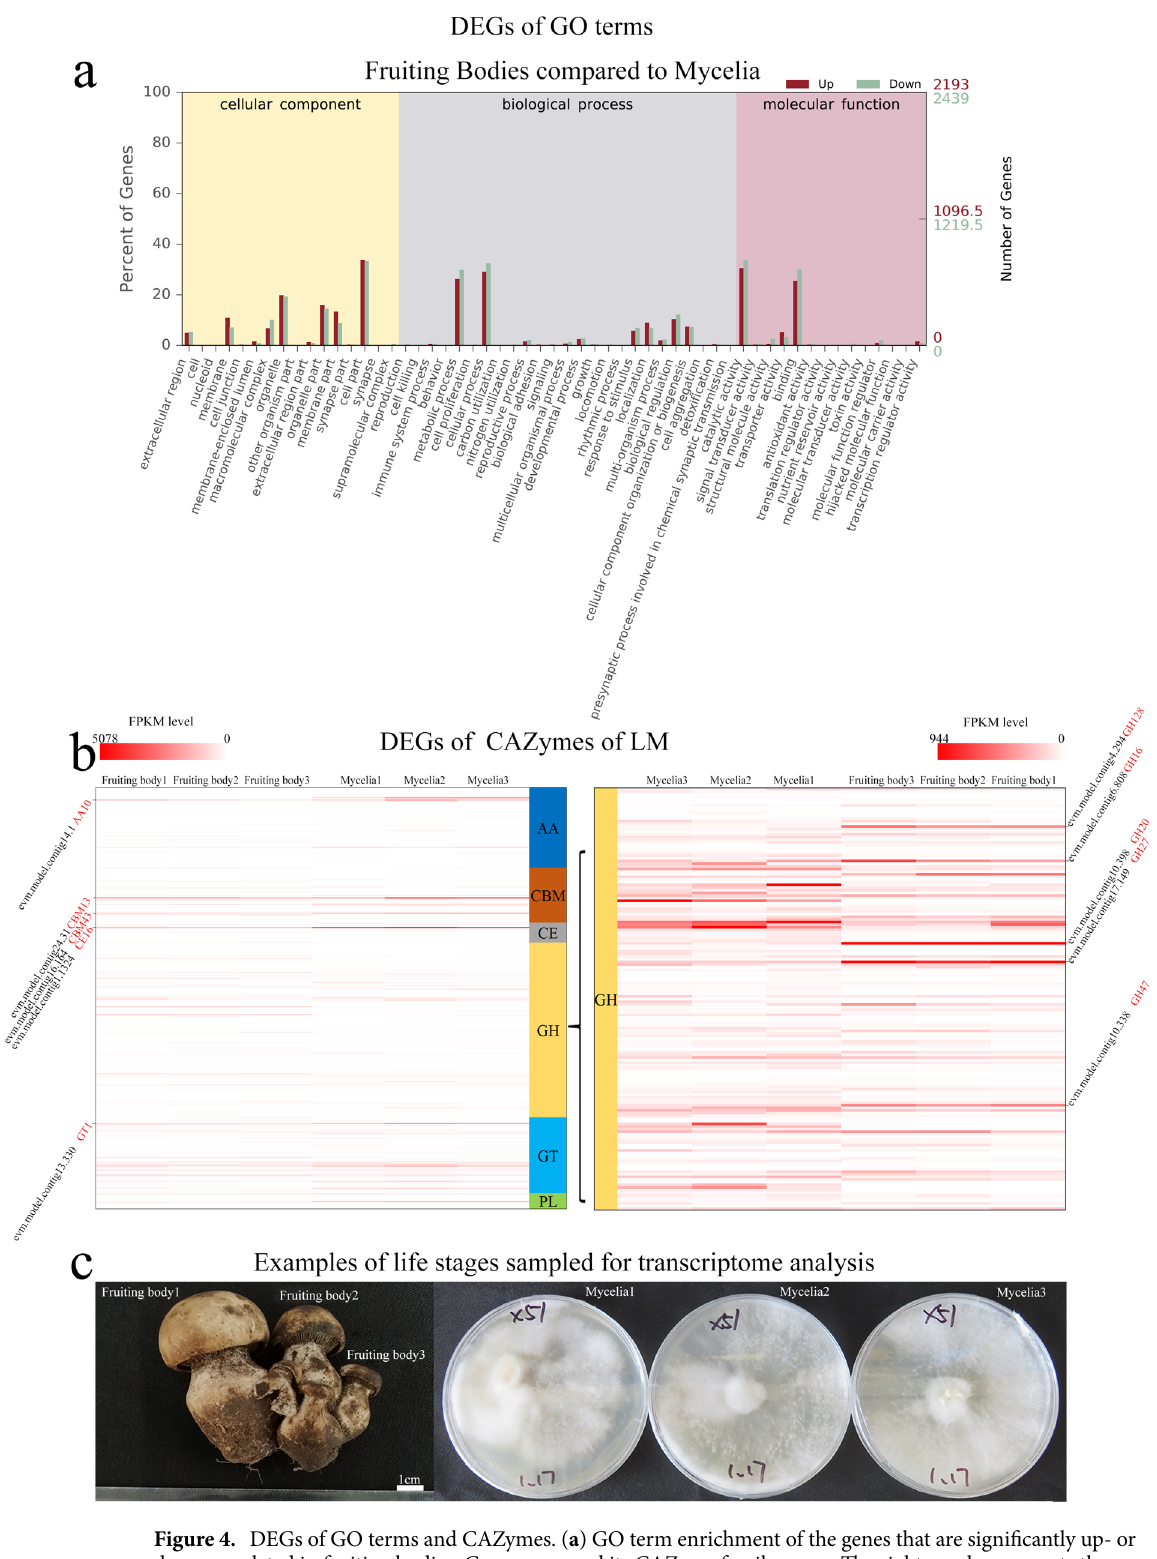
Figure 4. DEGs of GO terms and CAZymes. ( a ) GO term enrichment of the genes that are significantly up- or down-regulated in fruiting bodies. Gene name and its CAZyme family name. The right graph represents the genes within the GH module of CAZymes. Names to the right side indicate key gene names and their CAZyme family names. ( b ) Examples of fruiting bodies and vegetative (mycelia) organs of LM sampled for transcriptomic